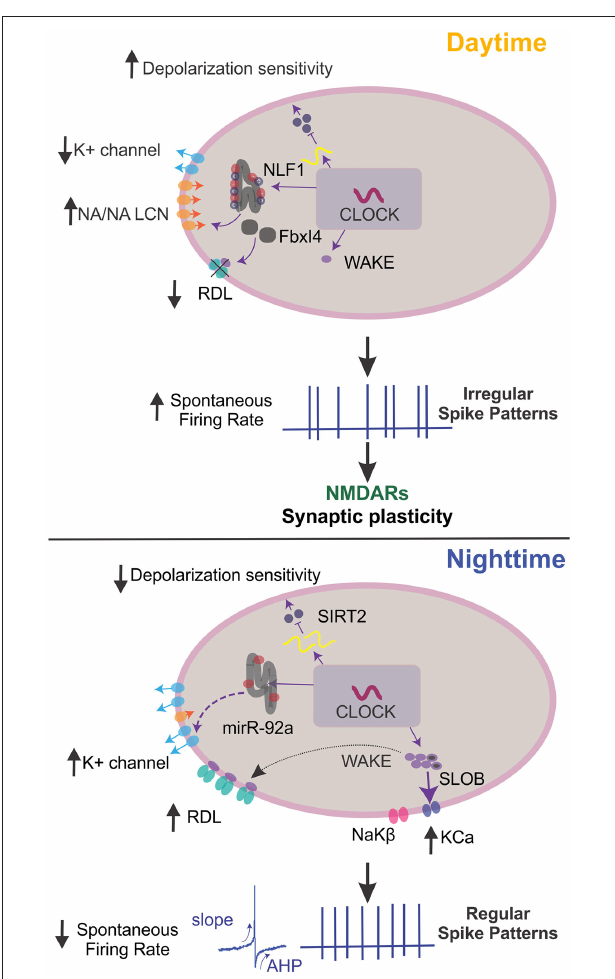
FIGURE 3 | Mechanisms of clock output genes that regulate neuronal excitability. In Drosophila , clock output genes modulate membrane potential dynamics to regulate sleep states. During the day, the clock drives high NCA localization factor 1 (NLF-1) activity. This activity, along with narrow abdomen (NA)/sodium leak channel non-selective protein (NALCN) in the lumen of the endoplasmic reticulum, enhances the activity of sodium leak channels and reduces potassium leak conductance to increase action potential (AP) firing rates, vice versa at night. During the night, microRNA-92a (miR-92a) regulates neuronal excitability by inhibiting SIRT2, a NAD-dependent deacetylase of the Sirtuin family and homolog of mammalian sir2/3 . This inhibition drives a decrease in calcium influx and depolarization sensitivity. At night, wide-awake (WAKE) expression is upregulated and interacts with the GABA A channel Resistance to dieldrin (RDL) to decrease spontaneous AP firing rates and resting membrane potential hyperpolarization. The clock-dependent upregulation of WAKE at night also promotes increased slow-poke binding protein (SLOB) and NaK β . This process then increases the K Ca current and Na/K ATPase activity, altering spike biophysical dynamics to promote regular firing. When posterior DN1s fire regularly, pars intercerebralis (PI) neurons reduce firing rates, increasing sleep quality. During the day, Fbxl4 is expressed and readily degrades RDL, which increases spontaneous AP rates and burst firing. Also, WAKE is minimally expressed, and clock neurons display irregular firing rates that drive NMDAR-dependent synaptic plasticity in the synapses between DN1p and PI neurons. This change in activity promotes and increases the firing rate in PI neurons, decreasing sleep quality. Note that not all described molecular mechanisms may function in all clock neurons. AHP,